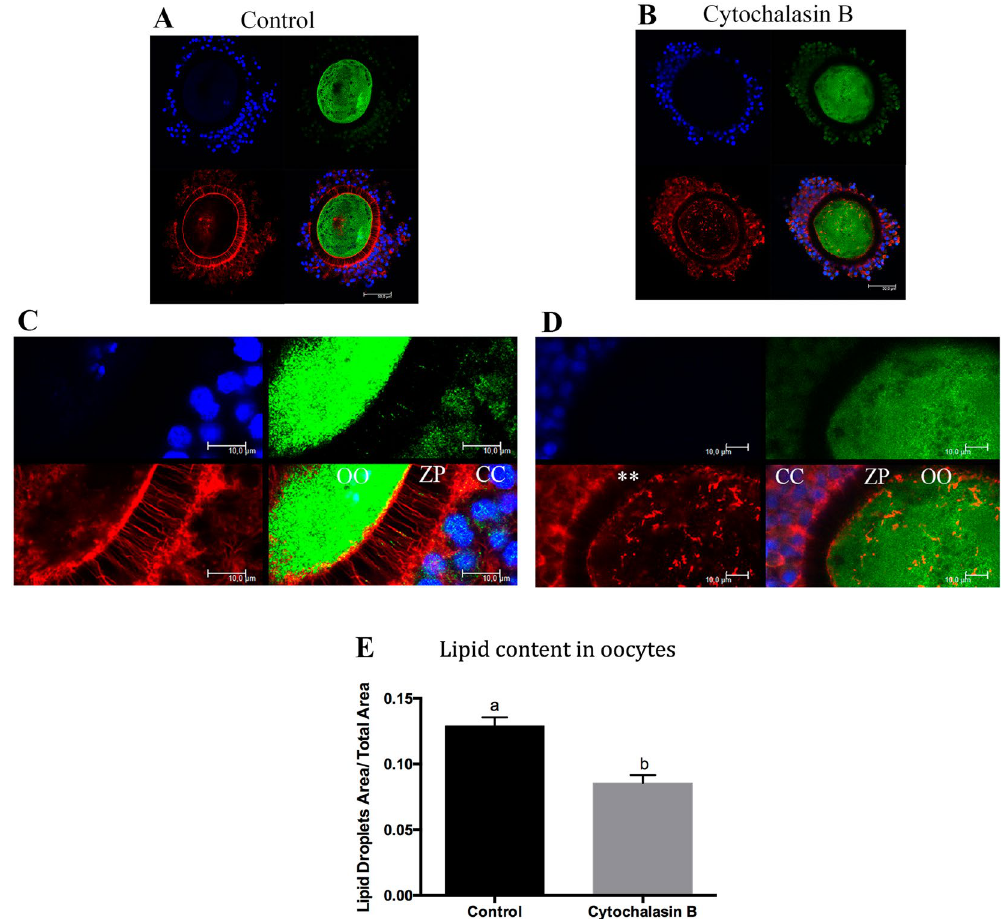
Figure 8. Confocal microscopic analysis of fatty acid binding protein 3 (FABP3) in cumulus-oocytes complexes (COCs) after in vitro maturation (IVM) in the absence (control) and presence of cytochalasin B. ( A ) and ( C ) The photomicrographs showing the presence of tranzonal projections (TZPs) and FABP3 in the control group. ( B ) and ( D ) Photomicrographs showing the lack of most parts of TZPs and FABP3 within the zona pellucida. FABP3 was immunostained using 488 Alexa Fluor (green); TZPs (actin) are stained with Alexa Fluor 647 phalloidin (red); nuclei are stained with DAPI (blue). Photomicrographs were obtained in 63x objective ( A and C ); and in 63 x objective zoomed 3.5 x ( B and D ). CC = cumulus cells; ZP = zona pellucida; OO = oocyte. ** Indicate the disassembly and blocking of TZP formation by cytochalasin B. A total of 10 control COCs and 10 cytochalasin treated COCs in vitro -matured for 9 hours were analysed and showed similar pattern; 6 additional control COCs and 6 additional cytochalasin B treated COCs are shown in Supplementary Fig. S10. ( E ) Lipid content in oocytes from COCs after IVM for 9 h in the absence (control) or presence of cytochalasin B. Lipid quantification was performed by fluorescence confocal microscopy to detect lipid droplets. Representative control and cytochalasin B-treated oocytes stained with BODIPY 493/503 are shown in Supplementary Fig. S11. The values for lipid content represent the ratio of the area of lipid droplets to the total oocyte area. Letters above bars indicate significant differences ( P < 0.05). Values are represented as mean ± standard error of the